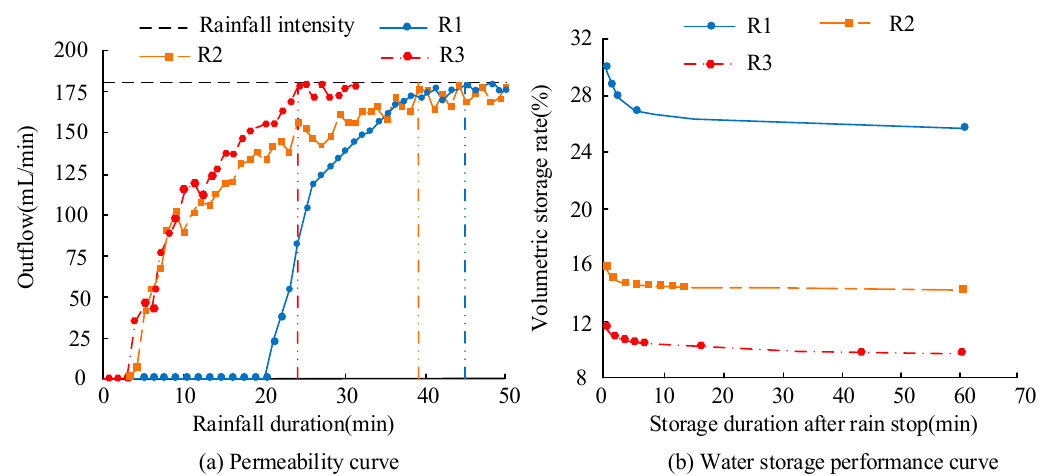
Figure 3. Seepage storage performance curve of different recycled brick concrete aggregate size frac- tions.